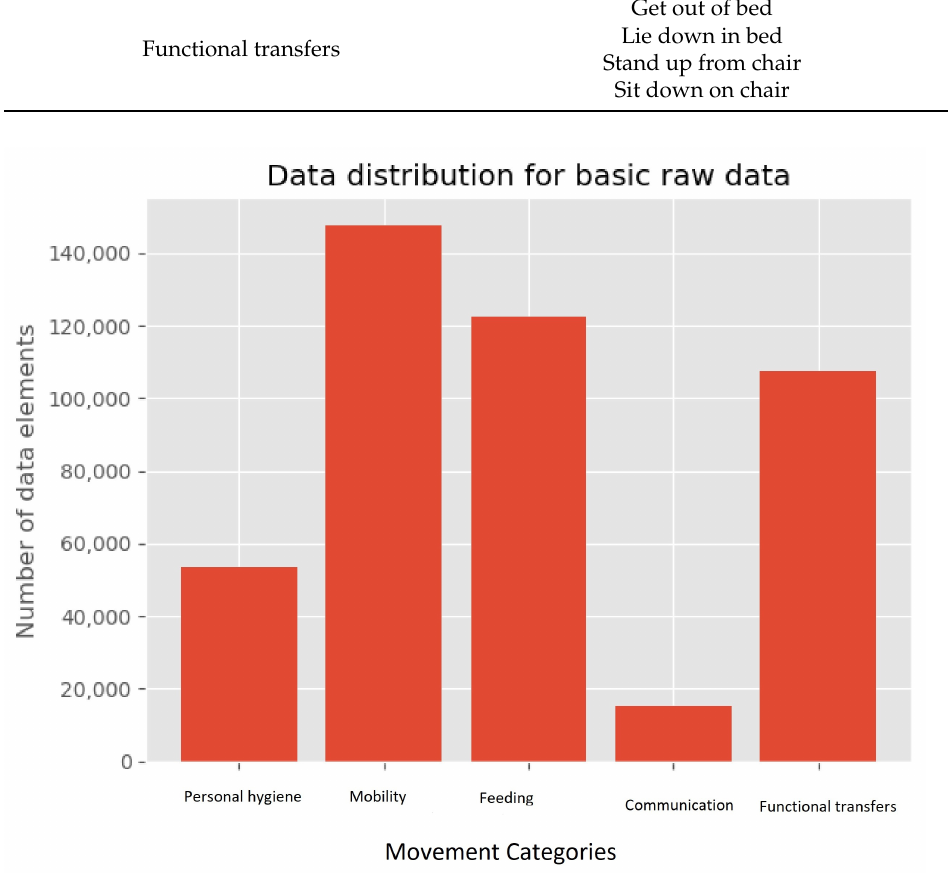
Figure 2. Basic Raw data distribution for the wrist-worn